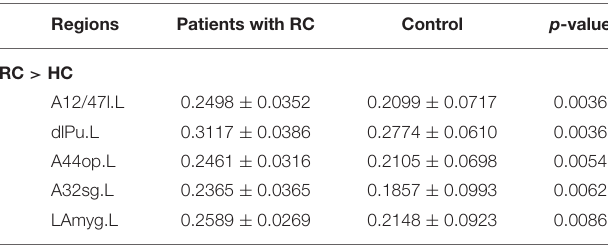
TABLE 3 | Brain regions with significant group effect in the nodal efficiency between patients with RC and HC for SN.